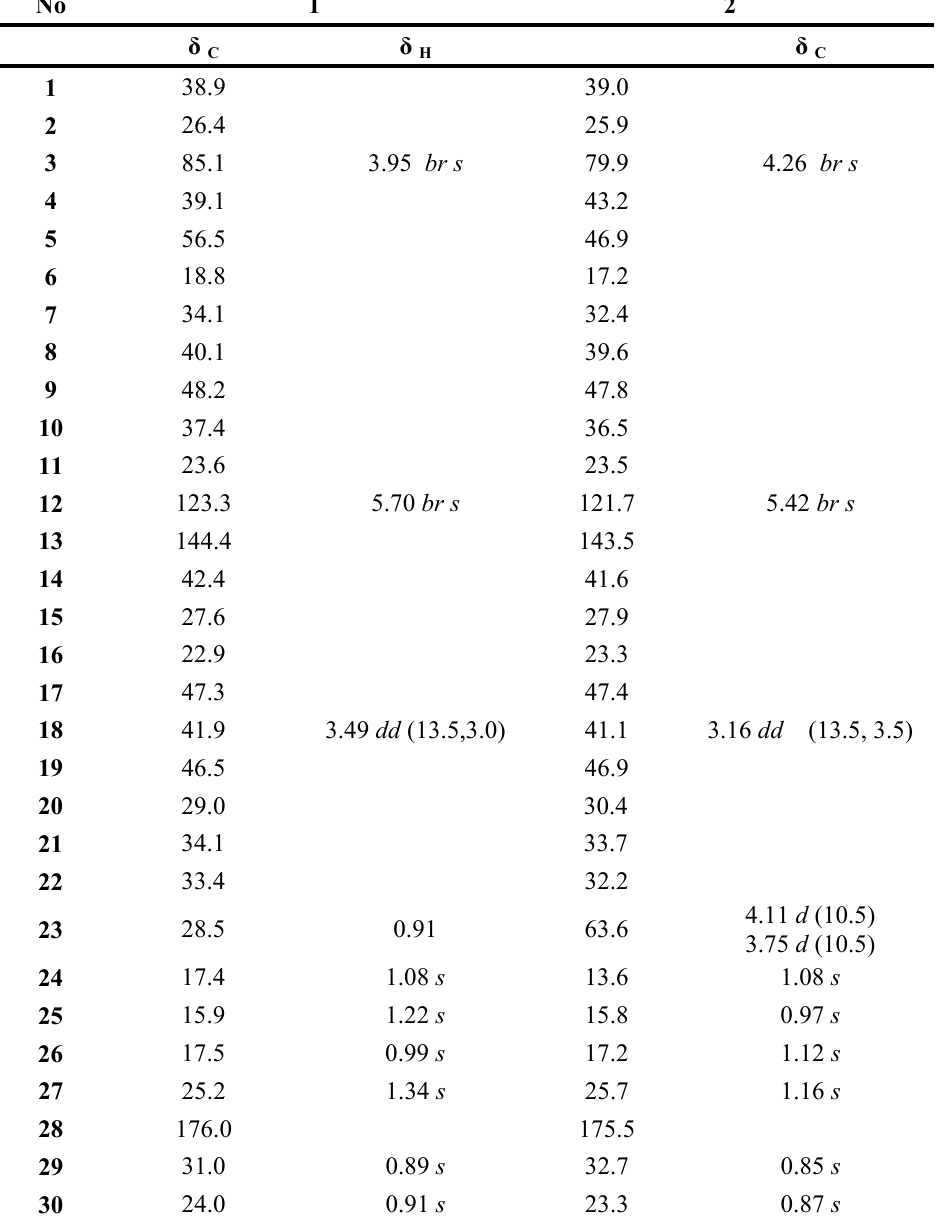
Table 1. 1 H- and 13 C-NMR data of aglycones in 1 and 2 (500/125 MHz, pyridine- d No